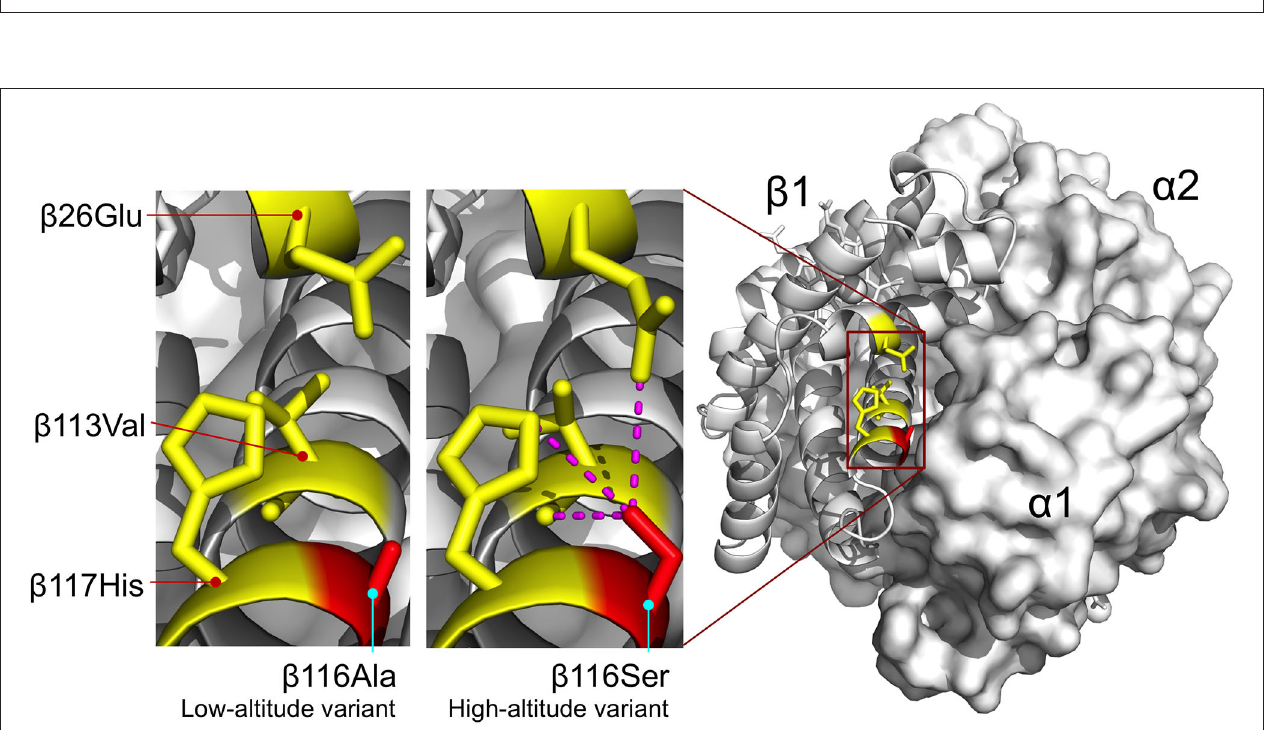
FIGURE 6 | Intrinsic O 2 -affinities [ P 50(stripped) , torr; mean ± SEM] of purified yellow-billed pintail rHb mutants measured in the absence of allosteric effectors. O 2 -equilibrium curves for each rHb mutant were measured in 0.1M HEPES buffer at pH 7.40, 37 ◦ C; [heme], 0.3mM. Numbers refer to residue positions in the β -chain subunit. “116Ala-133Leu” and “116Ser-133Met” are the two-site genotypes that predominate in low- and high-altitude populations, respectively. At each site, the derived (non-ancestral) amino acids are underlined in bold. Reproduced from Natarajan et al. (2015).